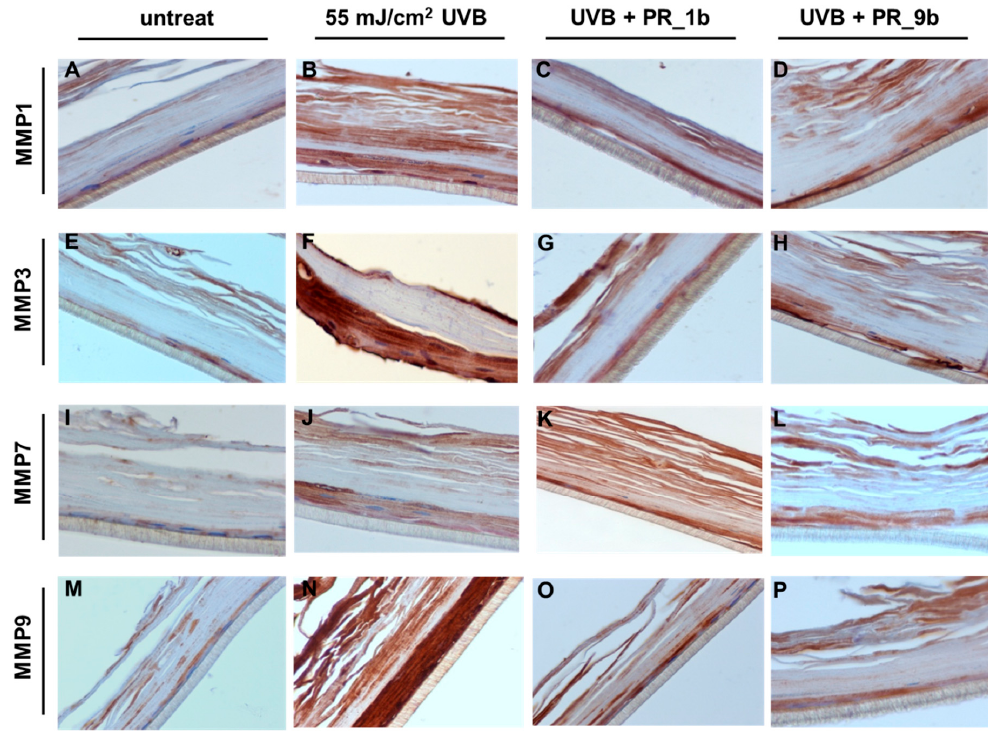
Figure 8. Propolis extracts protect from UVB-induced overexpression of MMPs in a reconstituted human skin model. Epiderm TM EPI-200 human skin tissues were pretreated with 20 μ g/mL of either PR_1b or PR_9b, for 2 h prior to UVB irradiation (55 mJ/cm 2 ) and incubated again in the presence